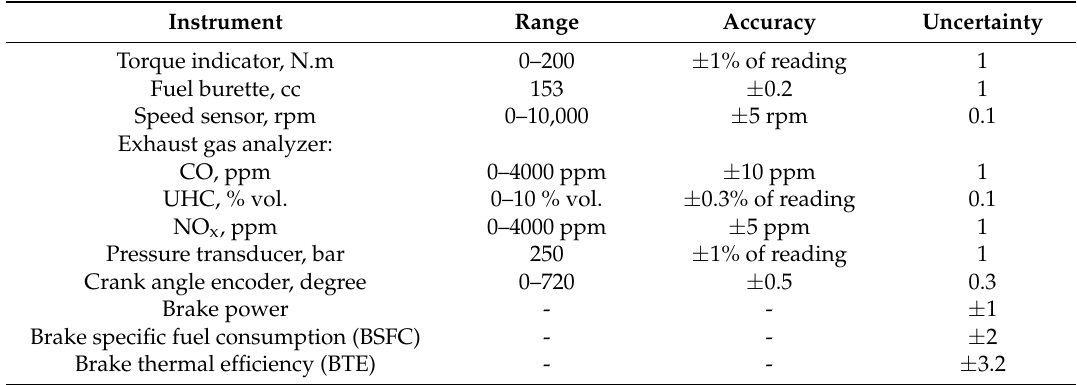
Table 4. Uncertainties of experimental